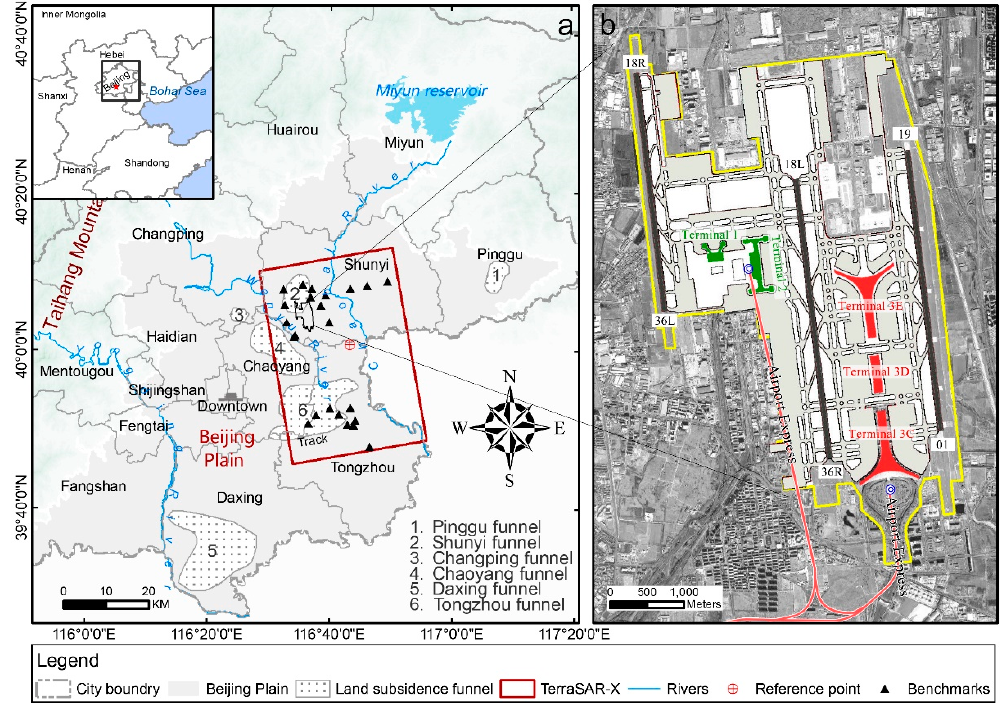
Figure 1. ( a ) The location of the study site and ( b ) a sketch map of the Beijing Capital International Airport (BCIA). The inset on the top left shows the base map of Beijing. The red rectangular represents the frame of the used TerraSAR-X data. The black triangles indicate the benchmarks used in this study. The black outline indicates the airport boundary. The red circle with the cross indicates the location of the reference point. The digits indicate the six sinking centers. The red lines and blue circles represent the airport express and stations,